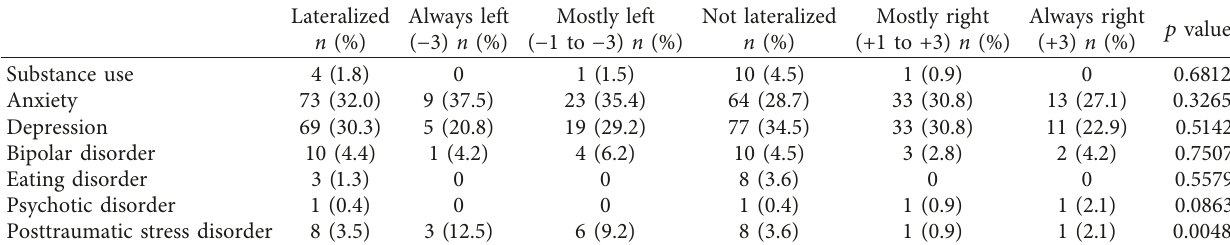
Table 7: Psychiatric comorbidities in patients with lateralized headaches.